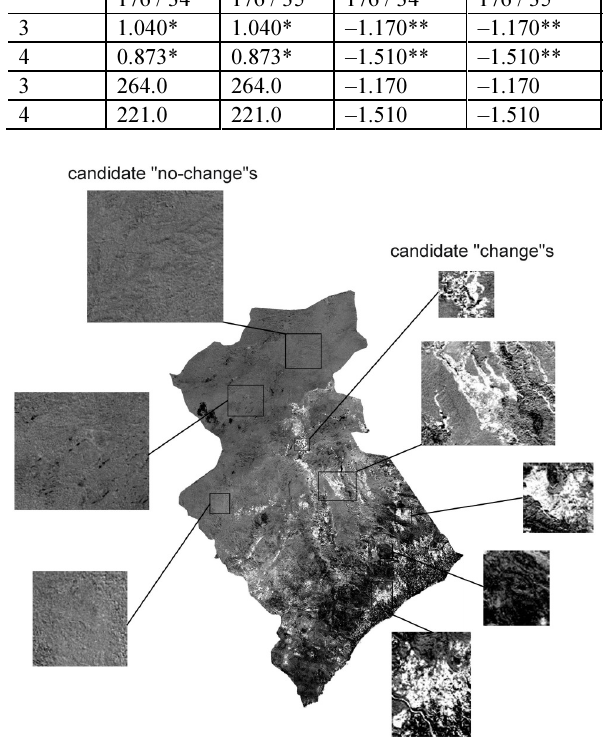
Fig.4. NDVI difference image for the study area and interpreta-